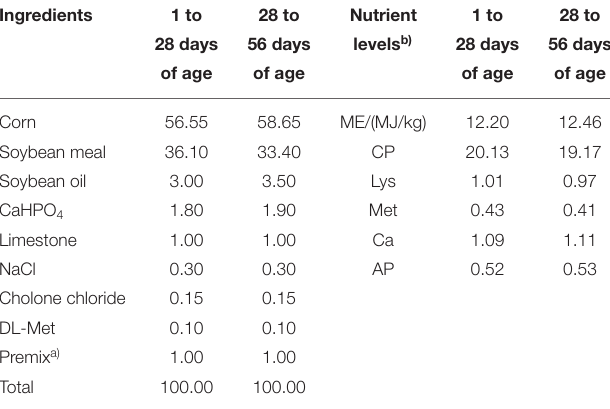
TABLE 1 | Composition and nutrient levels of basal diets (DM basis) %. Ingredients